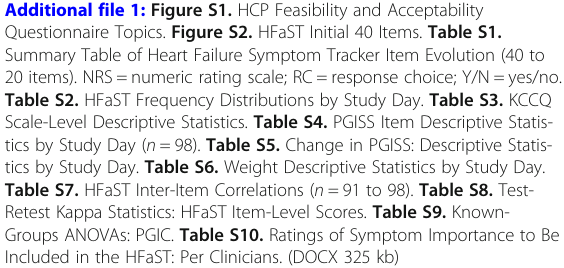
Table S2. HFaST Frequency Distributions by Study Day. Table S3. KCCQ Scale-Level Descriptive Statistics. Table S4. PGISS Item Descriptive Statis- tics by Study Day ( n = 98). Table S5. Change in PGISS: Descriptive Statis- tics by Study Day. Table S6. Weight Descriptive Statistics by Study Day. Table S7. HFaST Inter-Item Correlations ( n = 91 to 98). Table S8. Test- Retest Kappa Statistics: HFaST Item-Level Scores. Table S9. Known- Groups ANOVAs: PGIC. Table S10. Ratings of Symptom Importance to Be Included in the HFaST: Per Clinicians. (DOCX 325 kb) Abbreviations ER: Emergency room; HCP: Health care providers; HF: Heart failure; HFaST: HF Symptom Tracker; KCCQ-12: Kansas City Cardiomyopathy